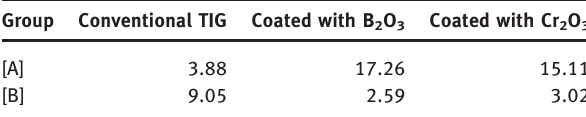
Table 3: Distribution of tungsten element in the weld bead (wt%). Group Conventional TIG Coated with B  O  Coated with Cr  O 